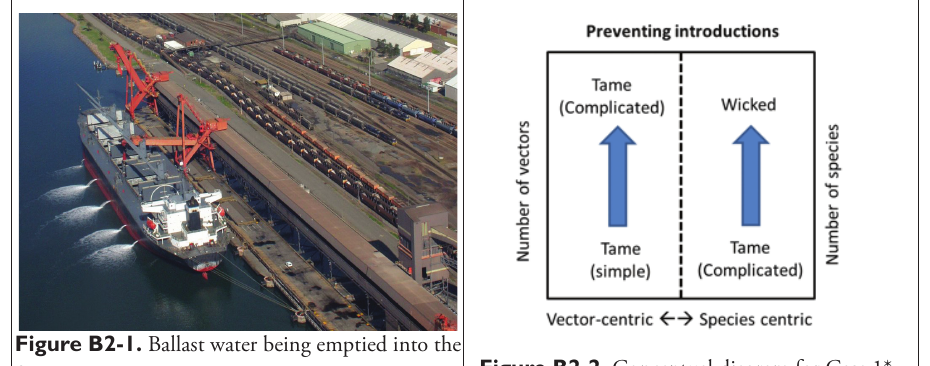
Figure B2-1. Ballast water being emptied into the St Lawrence River Figure B2-2. Conceptual diagram for Case